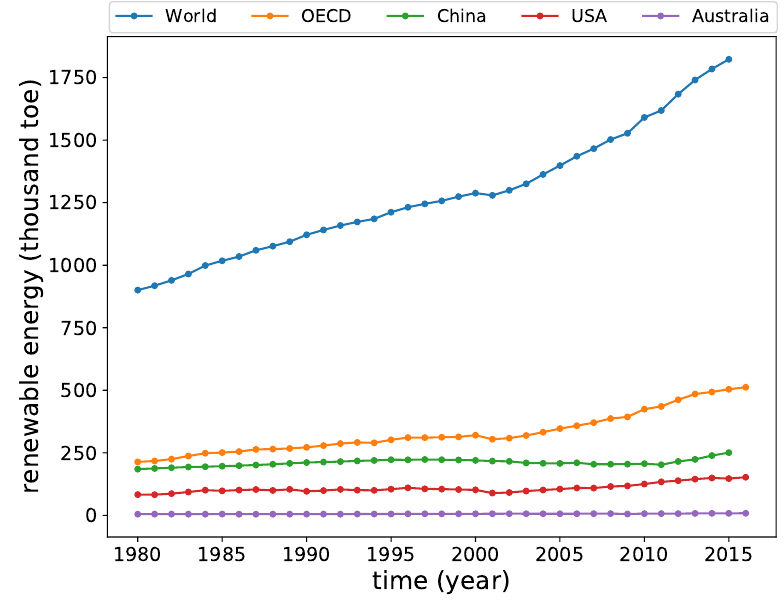
Figure 5. Renewable energy annual supply [45].